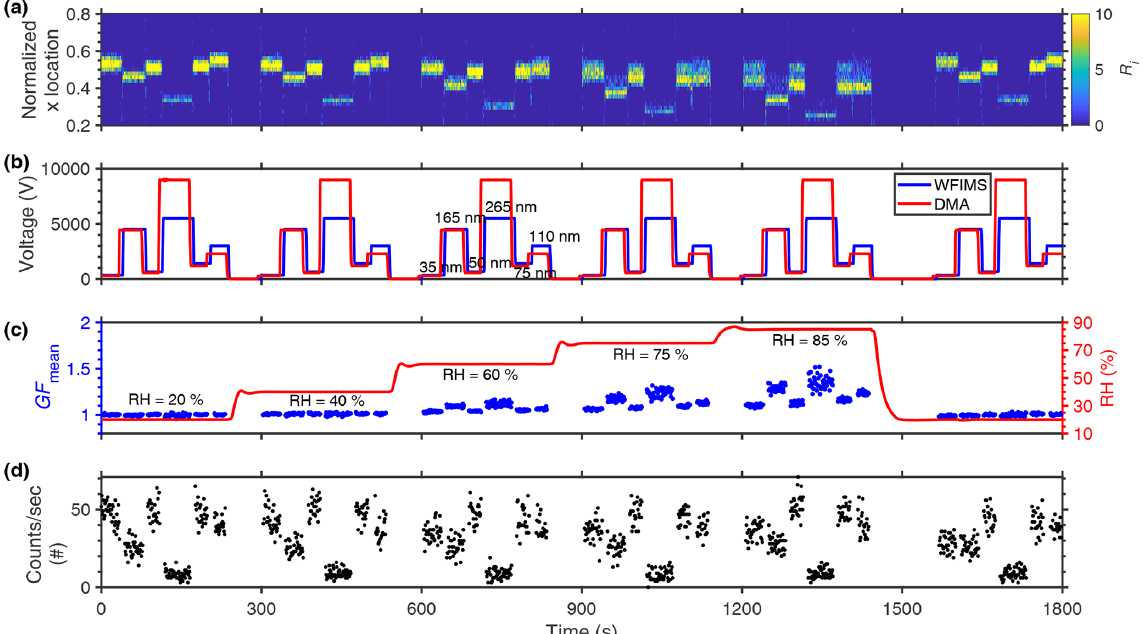
Figure 2. Example of the hygroscopic growth measurement sequence of ambient aerosols with six dry sizes (35, 50, 75, 110, 165, and 265nm) under five RHs (20%, 40%, 60%, 75%, and 85%). (a) The number of particles ( R i ) detected by WFIMS as a function of normalized x locations within the viewing window and time. (b) The DMA classifying voltage (red line) and WFIMS separator voltage (blue line). (c) RH inside the WFIMS separator and mean growth factor measured by HFIMS as a function of time. (d) Actual particle count rate of HFIMS as a function of